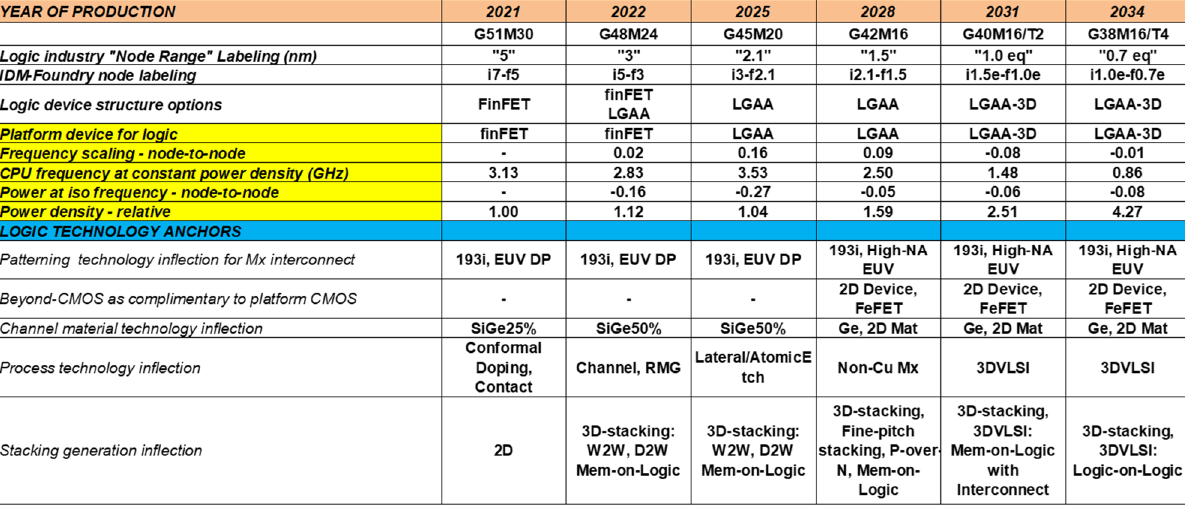
Figure 11. IRDS Roadmap for the next years. Notes: Mx—Tight-pitch routing metal interconnect,